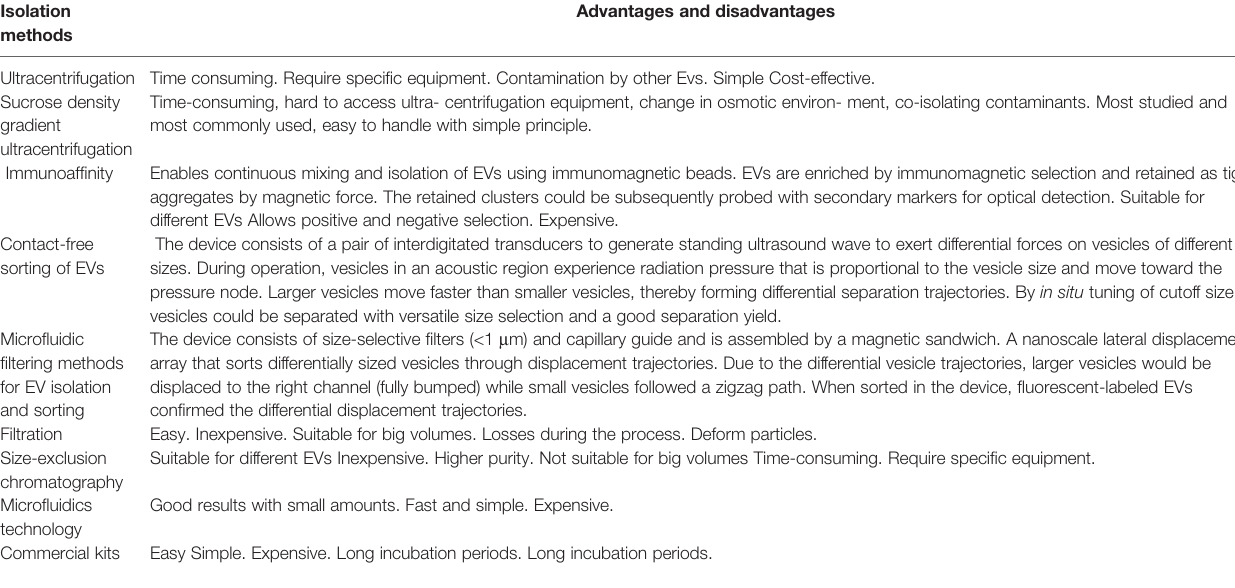
TABLE 1 | Summary of isolation methods for